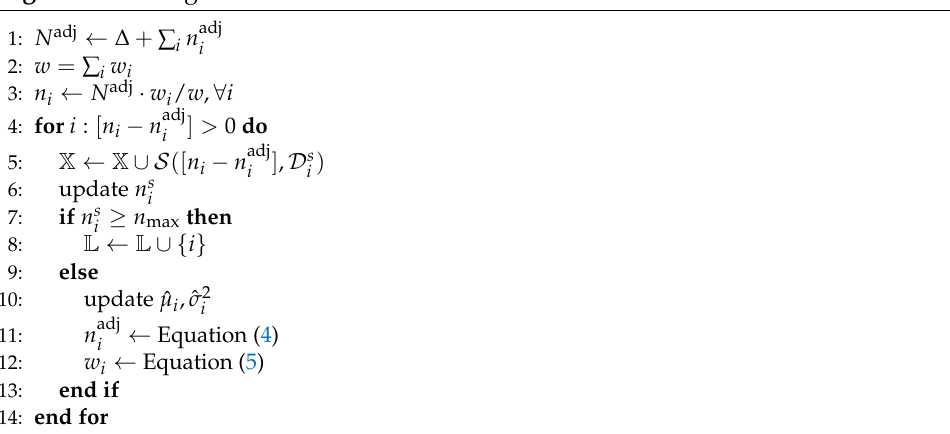
Algorithm 4 Budget